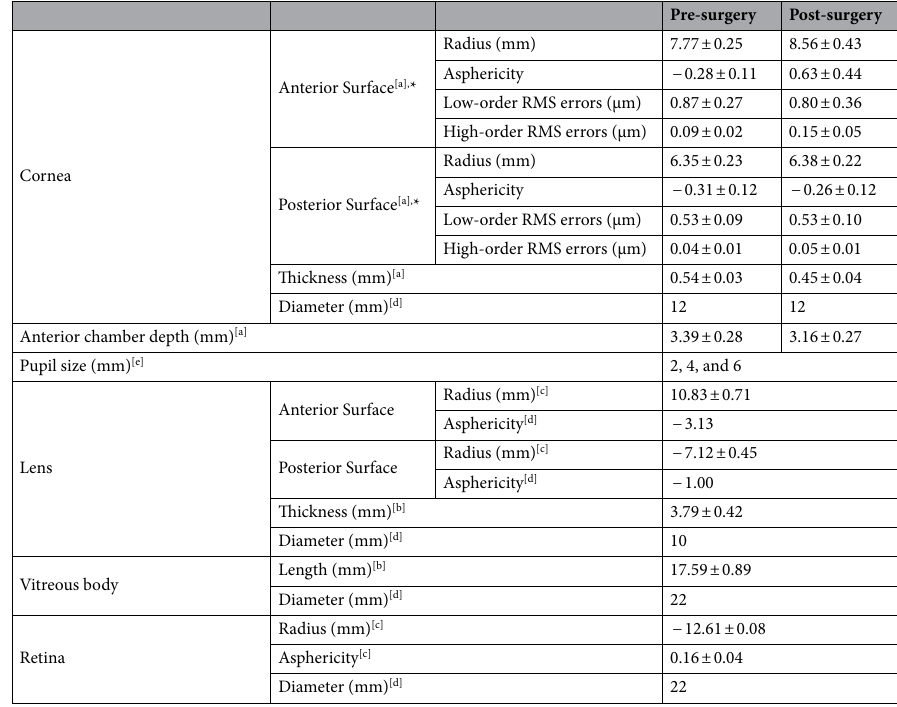
Table 1. General geometry of eye models for 134 right eyes before and 6 months after femto-LASIK. *The magnitudes of anterior and posterior corneal surfaces were fitted as sixth-order Zernike polynomials. [a] Measured by Pentacam (Oculus Optikgeräte GmbH). [b] Measured by Lenstar LS900 (Haag-Streit). [c] Estimated based on Eqs. (3–5) 39,41,45 . [d] Estimated based on the Navarro eye model 34 . [e] Set values for Zemax